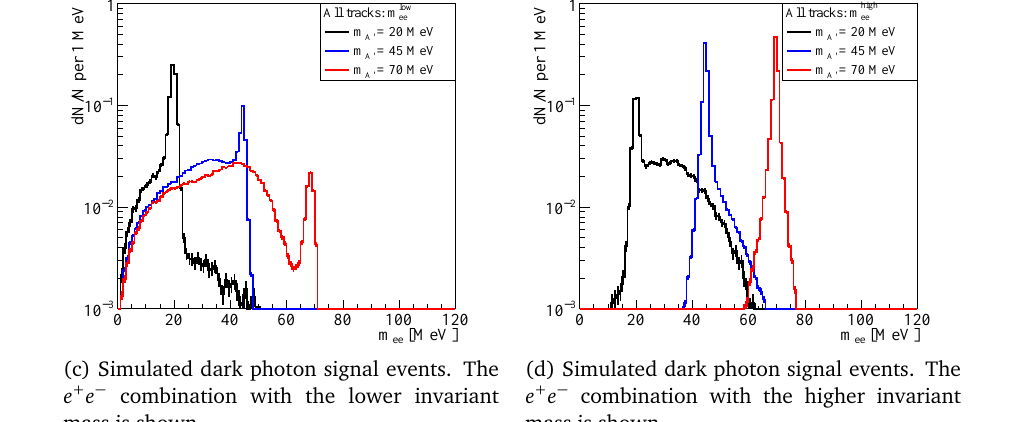
Figure 7: Distribution of the reconstructed invariant mass of e + e − pairs for simulated Standard Model background and signal from prompt dark photon decays. decays and decay promptly to an e + e − pair given the life time is